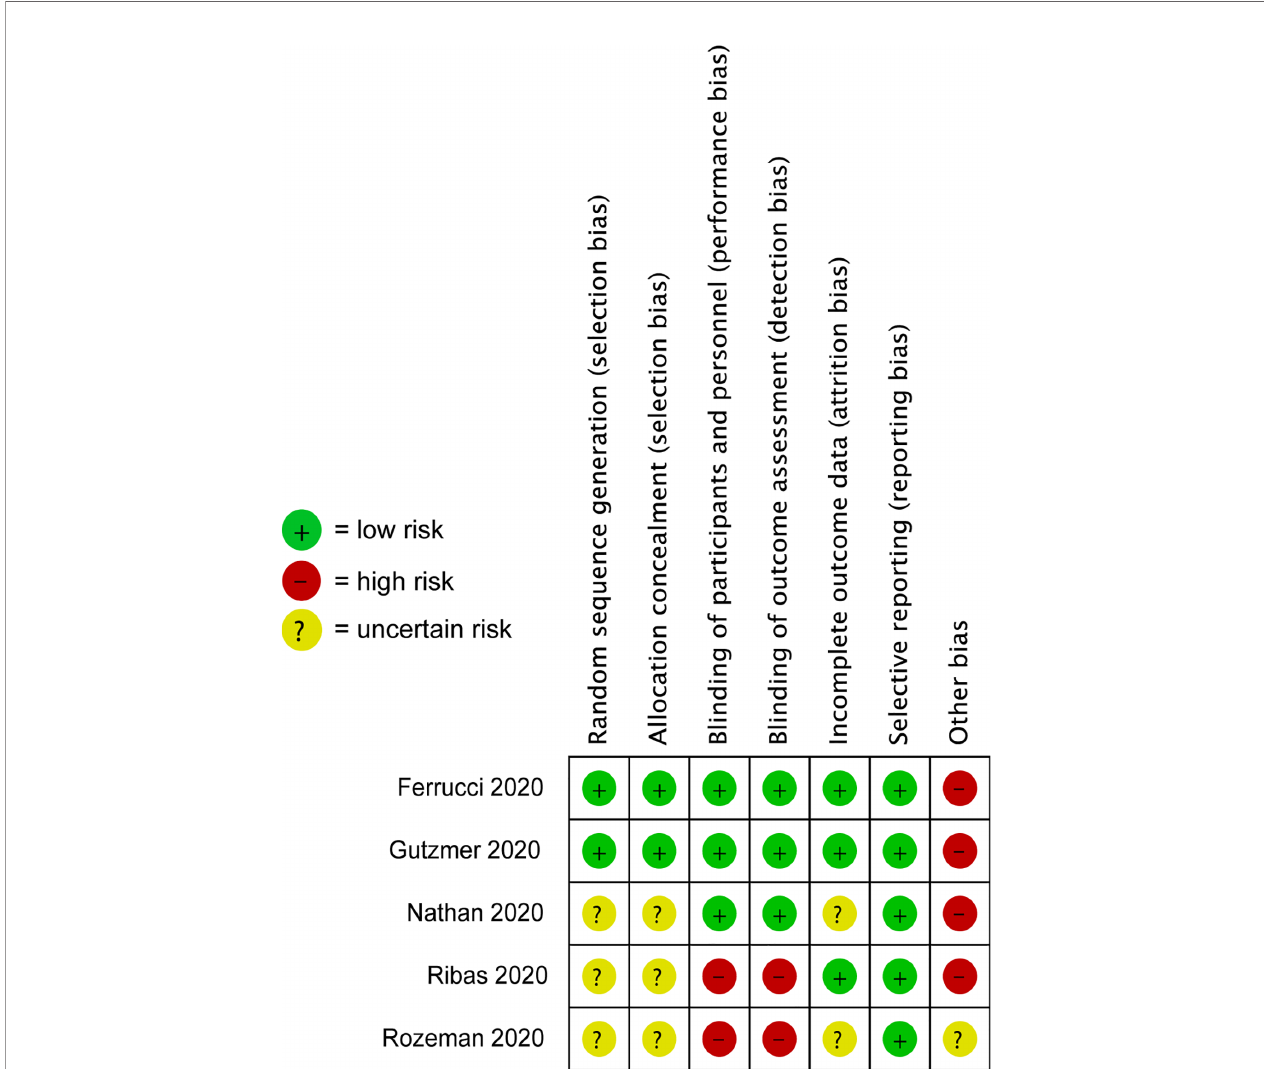
FIGURE 2 | Risk-of-bias assessment of randomized controlled trials (RCTs) included in